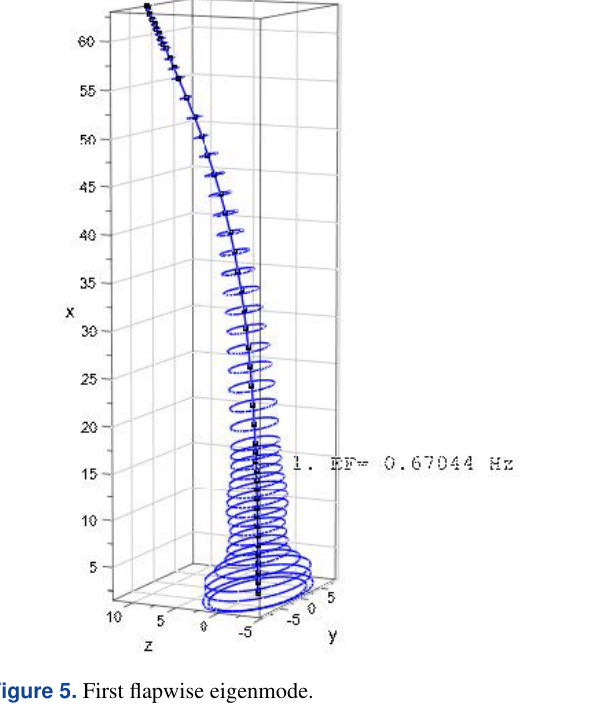
Figure 6. First edgewise eigenmode.